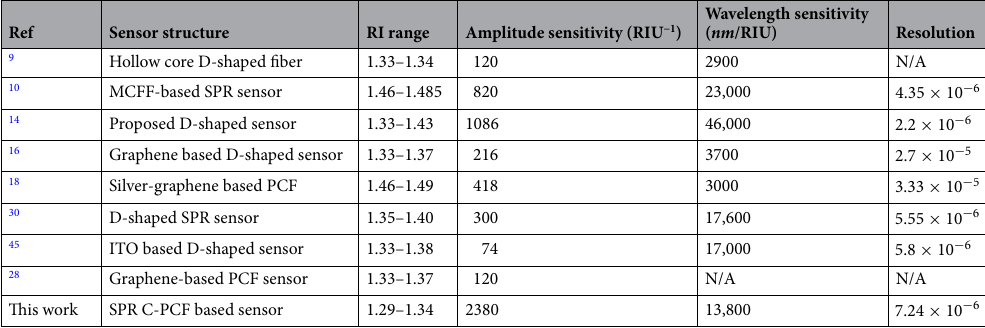
Table 1. Performance comparison of different sensors reported as highly sensitive SPR sensors.